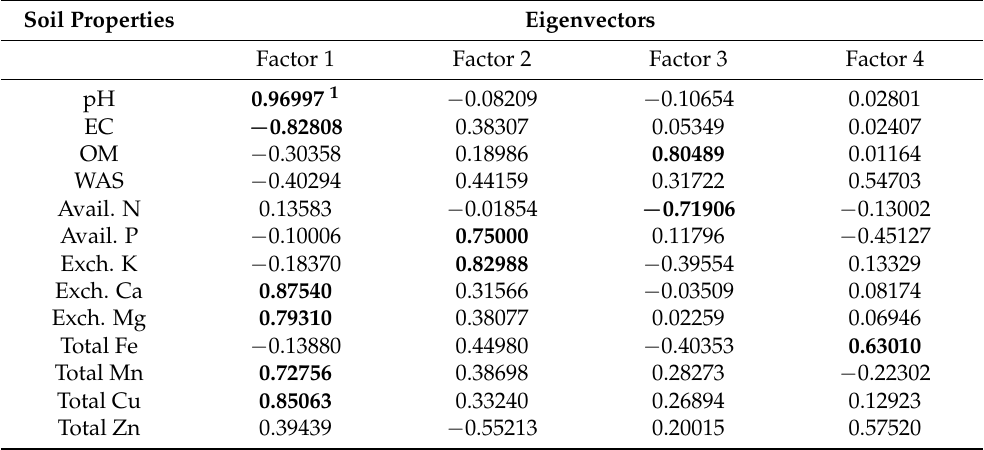
Table 5. The eigenvectors for variations of PCA by dataset in 0–60 cm soil properties. Soil Properties